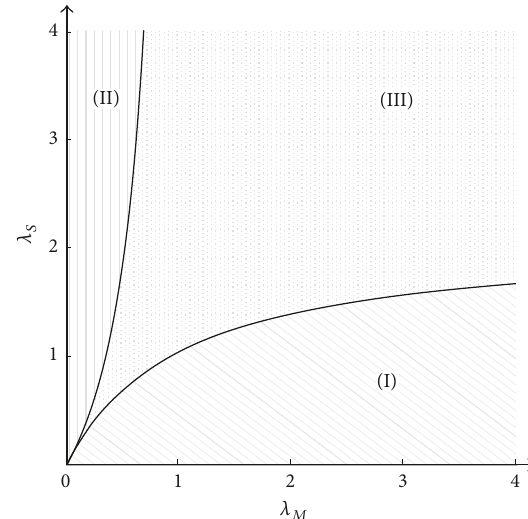
Figure 1: Different regions of 𝜆 𝑆 and 𝜆 𝑀 affecting the impact of 𝜏 on 𝑞 𝐹∗